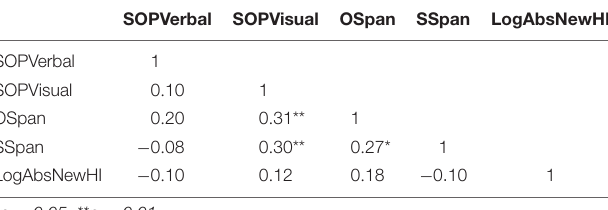
TABLE 4 | Correlation Matrix of SOPVerbal, SOPVisual, OSpan, SSpan, and LogAbsNewHI for American Group. SOPVerbal SOPVisual OSpan SSpan LogAbsNewHI